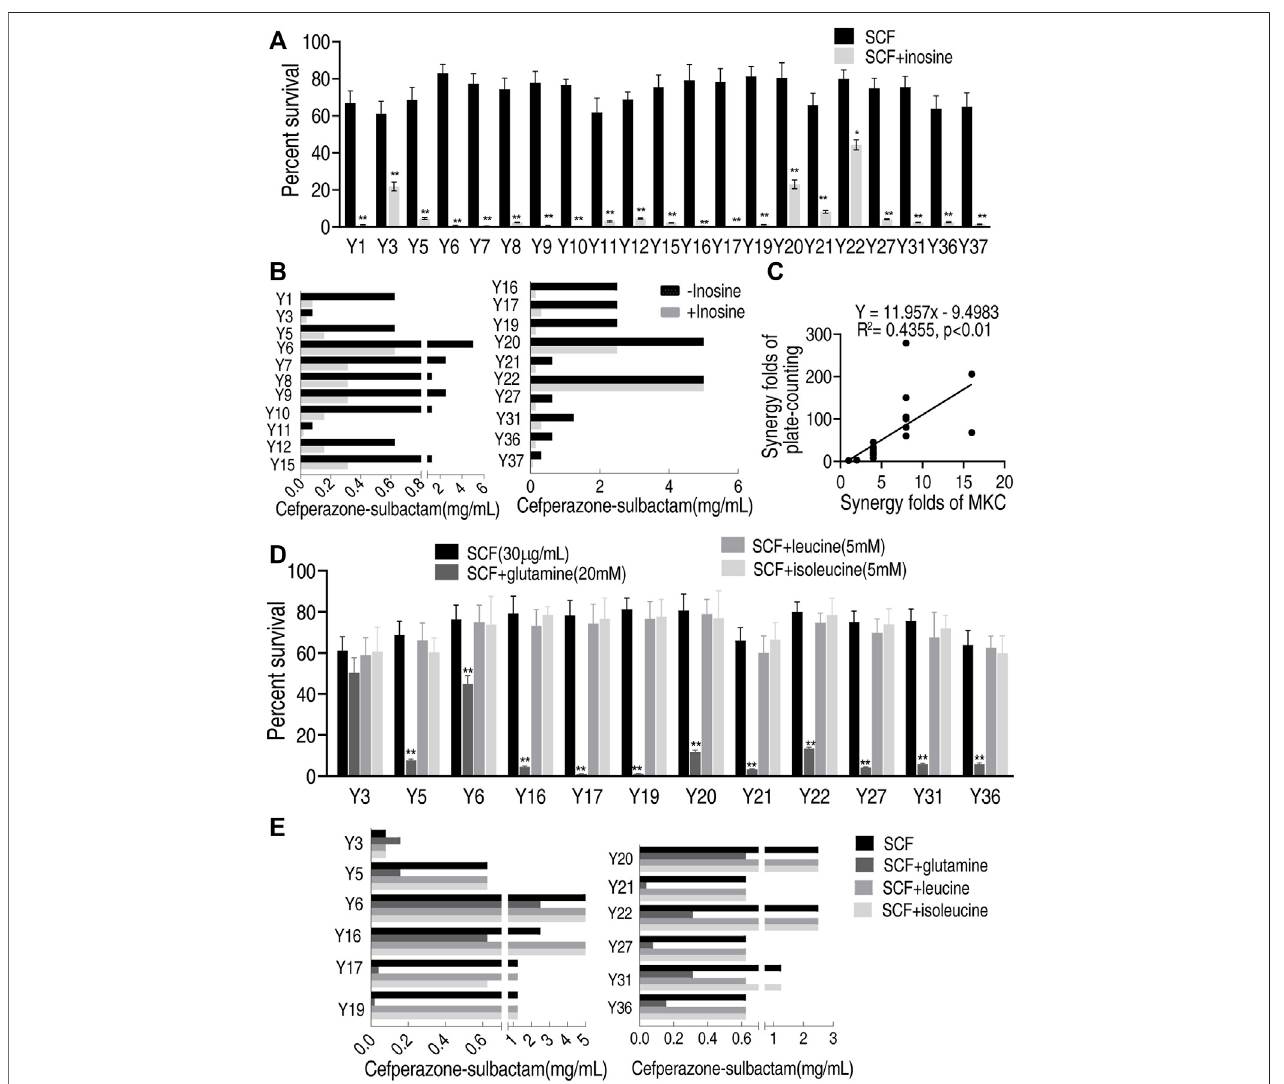
FIGURE6| Effectofdifferentmetabolitesonclinicallymultidrug-resistant E.coli strainsbyMKCtestinM9medium (A) Percentsurvivalof21clinicallyisolated E.coli strainsin the presence or absence of inosine in M9 medium by SCF (B) MKC test of 21 clinically isolated E. coli strains in the presence or absence of inosine in M9 medium by SCF (C) Correlation analysis between MKC test and plate-counting method (D) Percent survival of 12 clinically isolated E. coli strains in the presence or absence of glutamine, leucine, isoleucine respectively in M9 medium by SCF (E) MKC of 12 clinically isolated E. coli strains in the presence or absence of glutamine, leucine, isoleucine respectively in M9 medium by SCF. Results are displayed as mean ± SEM and three biological repeats are performed. Signi fi cant differences are identi fi ed * p < 0.05, ** p < 0.01.